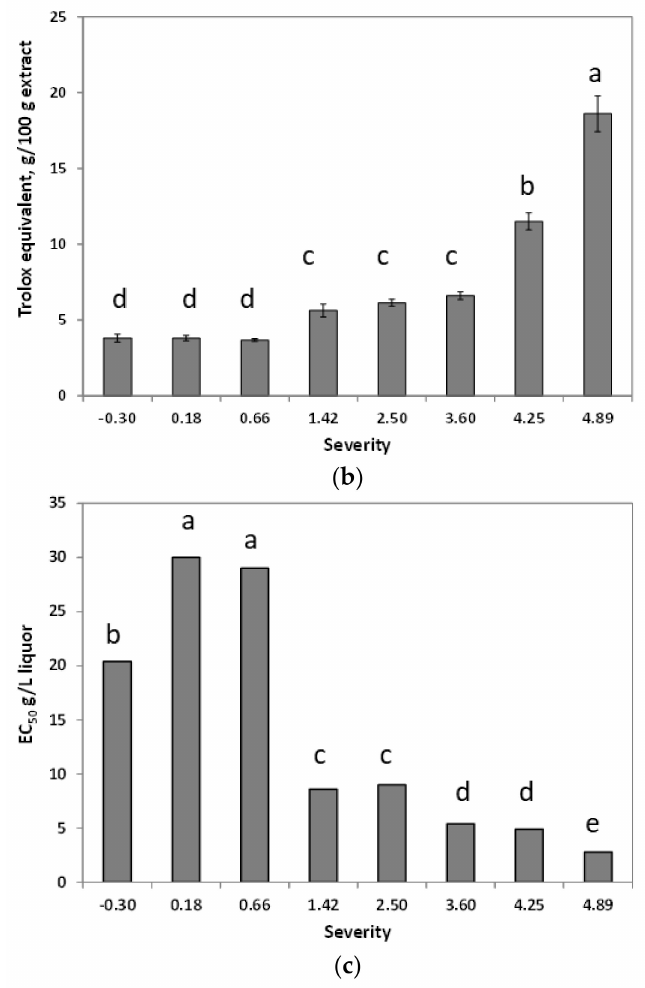
Figure 4. E ff ect of severity on ( a ) phenolic content of autohydrolysis liquors; ( b ) ABTS + · radical scavenging capacity of autohydrolysis liquors, expressed as Trolox equivalents (TEAC); ( c ) DPPH · radical scavenging capacity of autohydrolysis liquors, expressed as EC 50 . Letters represents the statistical